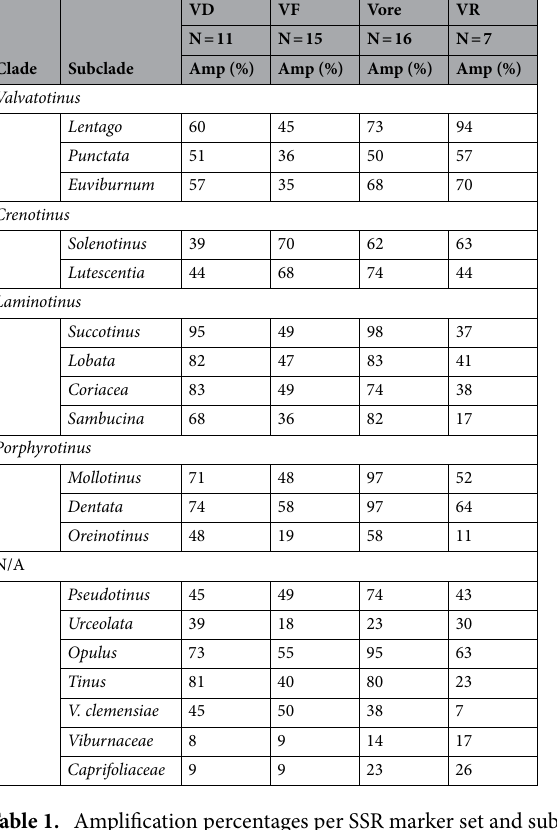
Table 1. Amplification percentages per SSR marker set and subclade. VD Viburnum dilatatum markers; VF V. farreri markers; Vore V. Oreinotinus subclade markers; VR V. rufidulum markers; N number of markers in the set; Amp percent amplification within the expected base pair size.